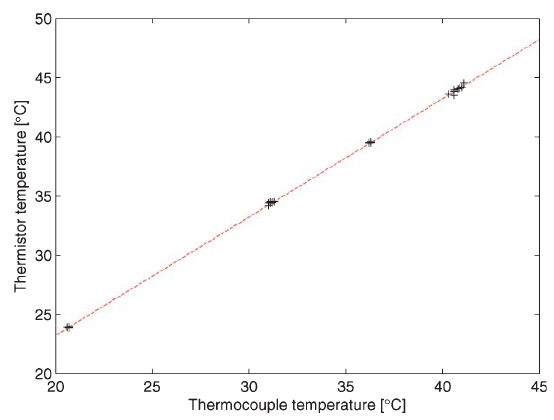
Fig. 10. Thermistor temperature versus thermocouple temperature. The linear fit described by Equation 15 is also shown.